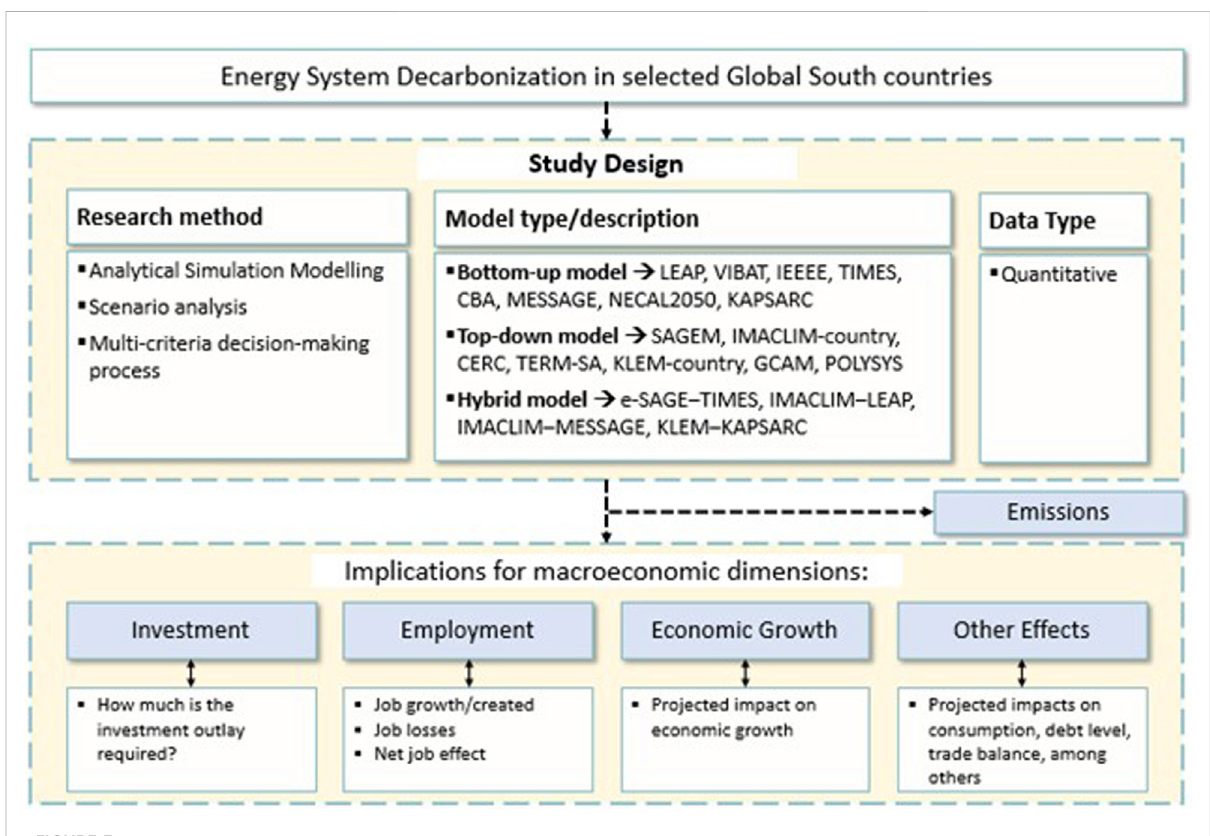
FIGURE 3 Pictorial depiction of the approach to literature review synthesis of evidence. Source: Authors ’